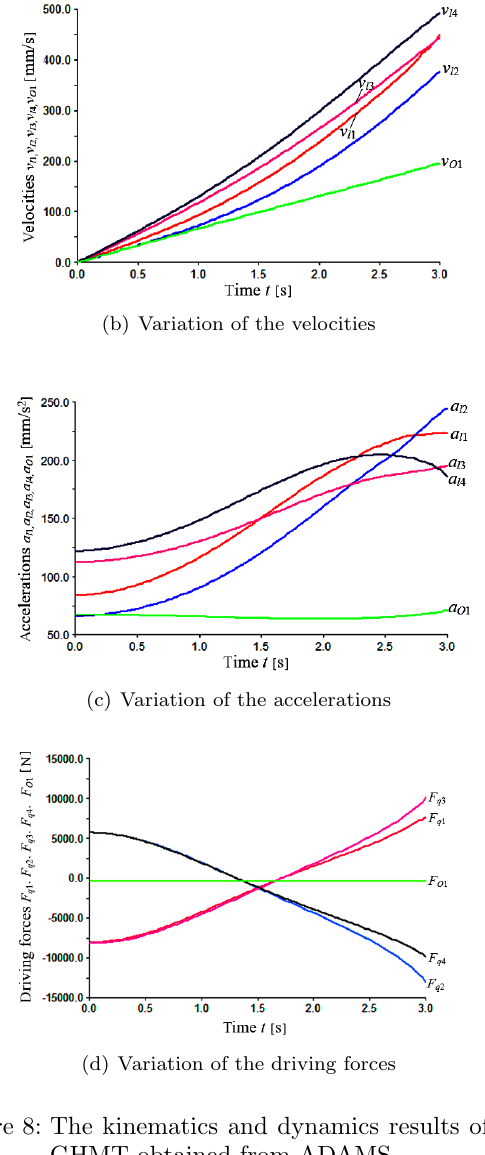
Figure 7: The kinematics and dynamics results of the GHMT